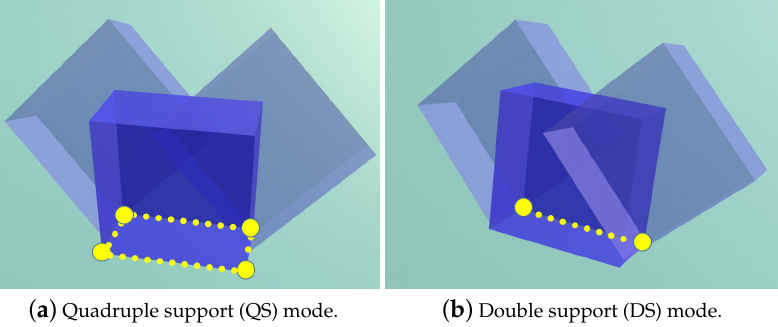
Figure 9. Changes in the object’s rotational vertices ( a ) in the QS mode when four vertices are in contact with the table and ( b ) in the DS mode when two vertices are in contact with the